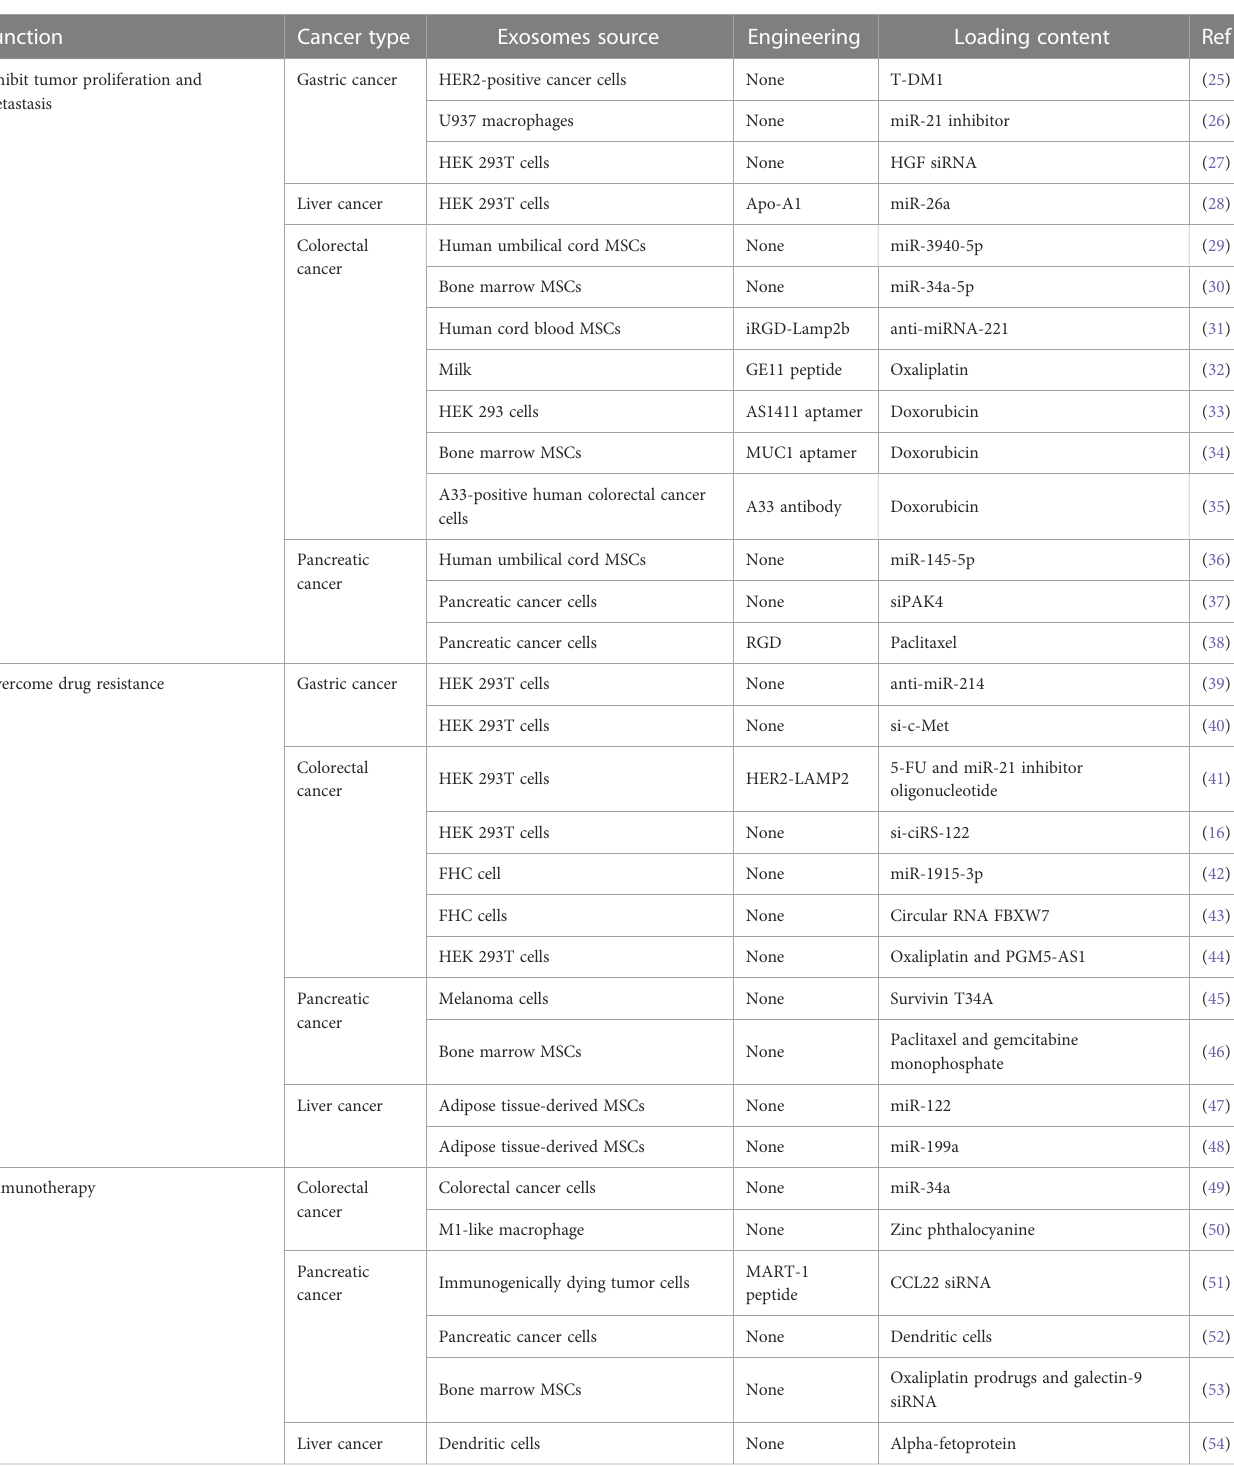
TABLE 1 Exosomes as drug delivery systems for the treatment of gastrointestinal cancers. Function Cancer type Inhibit tumor proliferation and